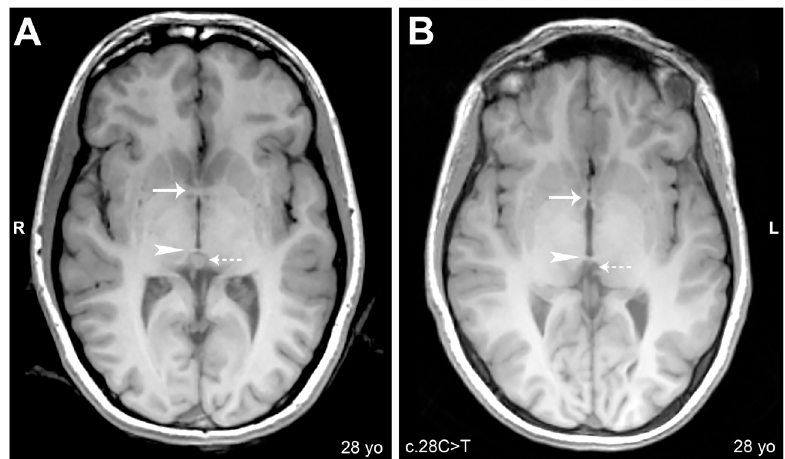
Figure 1. Anterior commissure, posterior commissure, and pineal gland: Axial cerebral T1-weighted magnetic resonance images, slice thickness 1.2mm. ( A ) Subject 6C: Arrow shows normal anterior commissure; arrowhead shows normal posterior commissure; dashed arrow shows normal pineal gland. ( B ) Subject 6A: Arrow shows reduced anterior commissure; arrowhead shows normal posterior commissure; dashed arrow shows absence of pineal